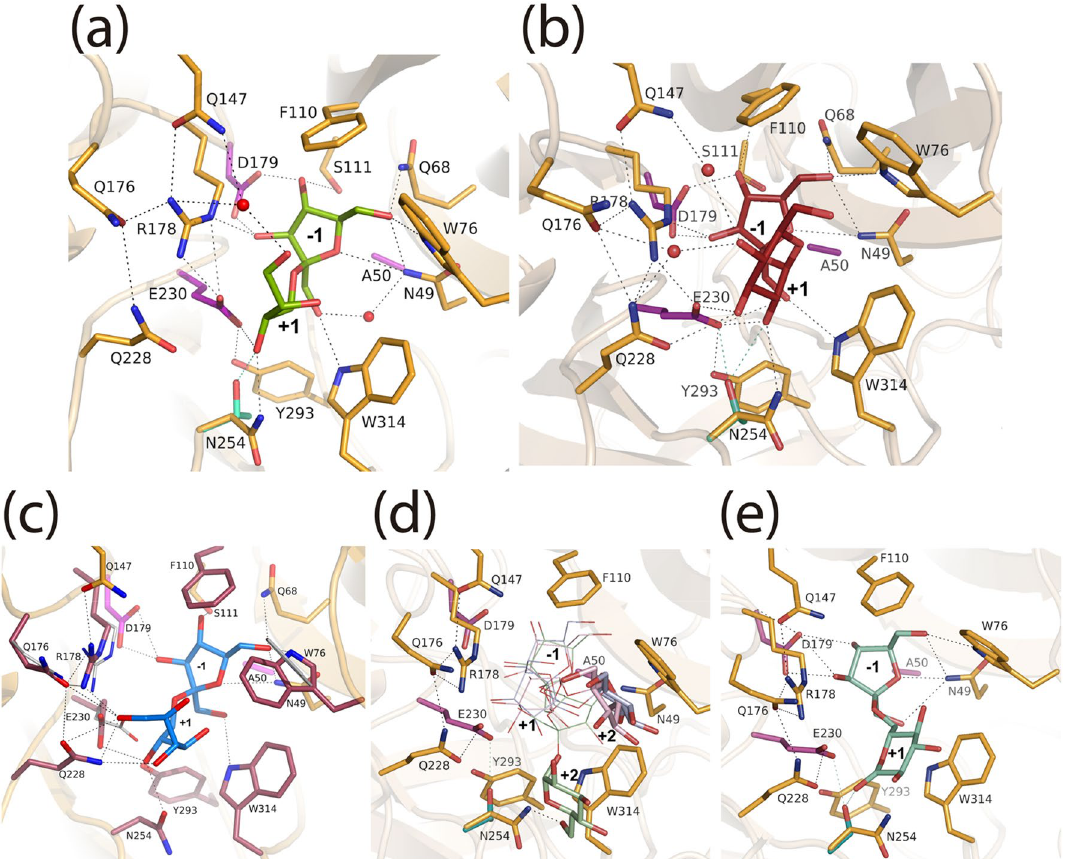
Figure 2. Detailed image of the atomic interactions produced at the Ffase active site. Crystallographic complexes with ( a ) fructosyl-erythritol (green) or ( b ) sucrose (prune) are shown, with relevant residues represented as orange sticks, and the catalysts in magenta. Polar interactions are represented as dashed lines. The modelled Thr in the N254T mutant is represented in cyan, with its putative interactions in the same color. ( c ) Docking simulation of the fructosyl-mannitol derivative (marine) into the Ffase active site, as computed by AutoDock Vina; the residues considered as flexible in the calculation are colored in raspberry, showing in grey sticks the corresponding position observed in the fructosyl-erythritol of those that have moved in the model. ( d ) The modelled position of the products 6-kestose (pale green), 1-kestose (pale blue), and neokestose (pink), reported previously 2 , is shown with the terminal sugars located at subsite + 2 highlighted as broader sticks. ( e ) The modelled position of blastose showing its putative interaction with Thr in the mutant